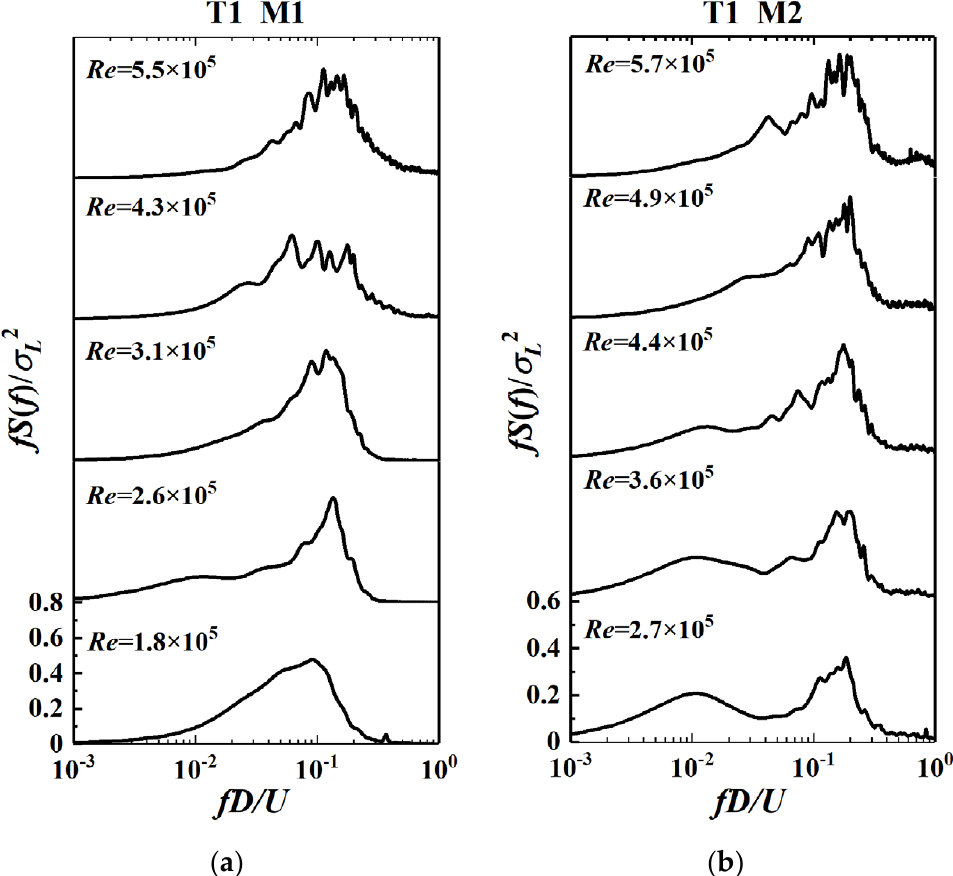
Figure 13. Power spectrum of the local lift coefficient at 0.5 H of models under different Re. ( a ) M1; ( b ) M2.